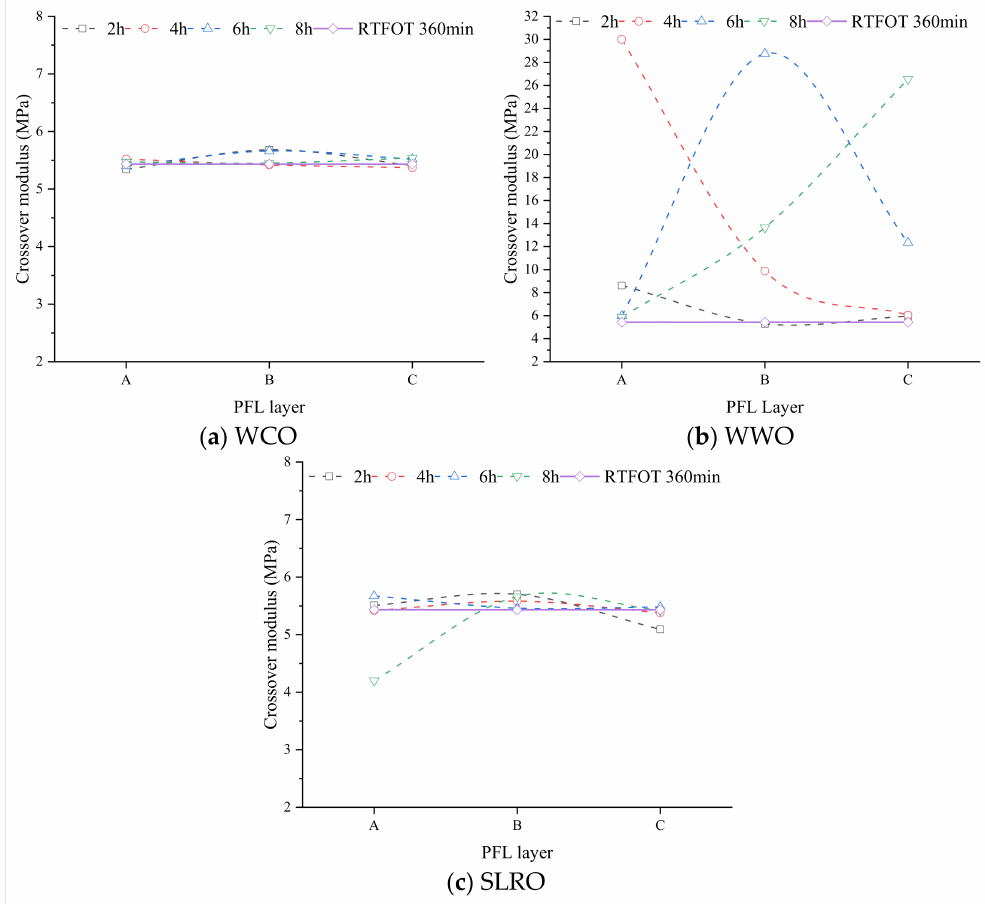
Figure 18. Effect of PFL layer on crossover